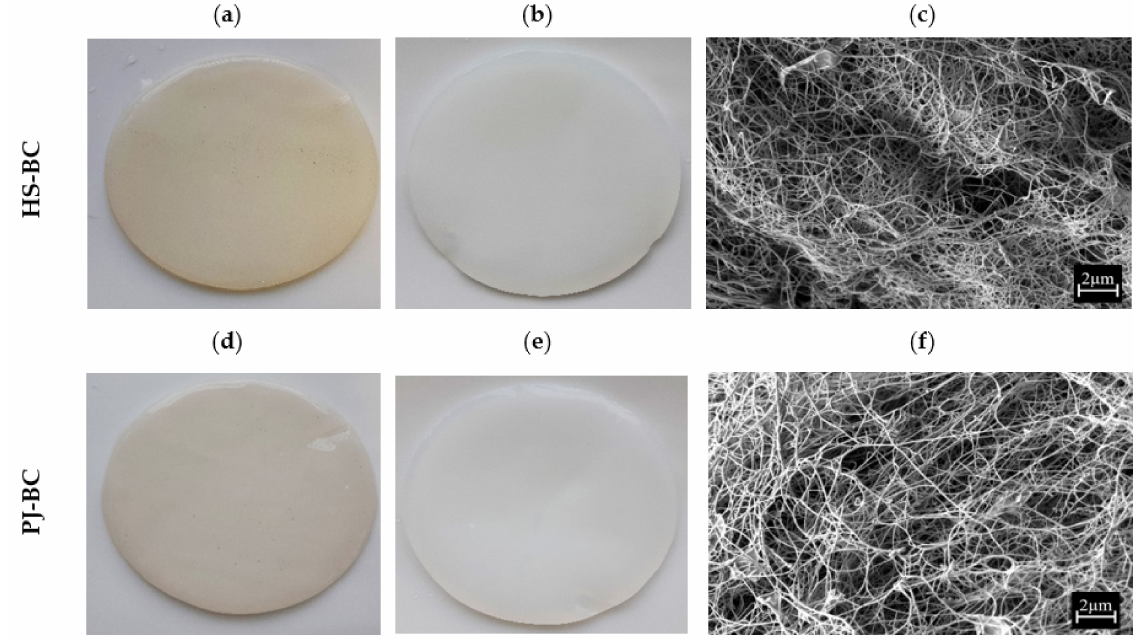
Figure 4. Macromorphology of BC from K. xylinus ATCC 53524: ( a , d ) before purification; ( b , e ) after purification; ( c , f ) mi- cromorphology of BC from K. xylinus ATCC 53524 after purification, magnification 10,000 × (SEM, Auriga 60, Zeiss, Oberkochen, Germany).